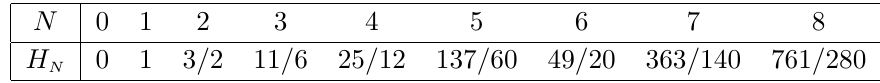
Table 1 . First few harmonic